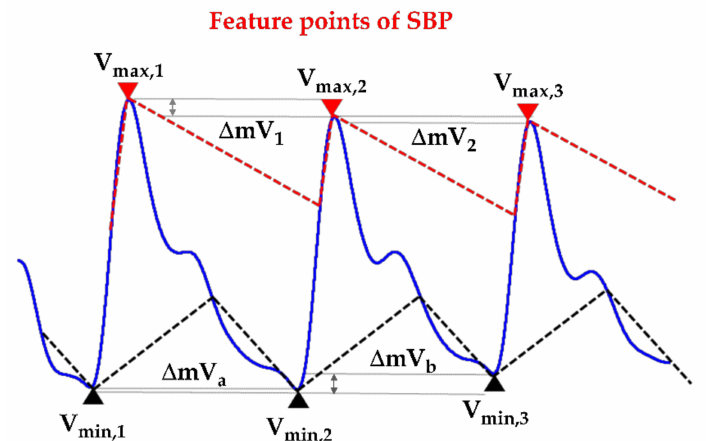
Figure 6. Peak and valley detection algorithm for pressure pulse wave (PPW)